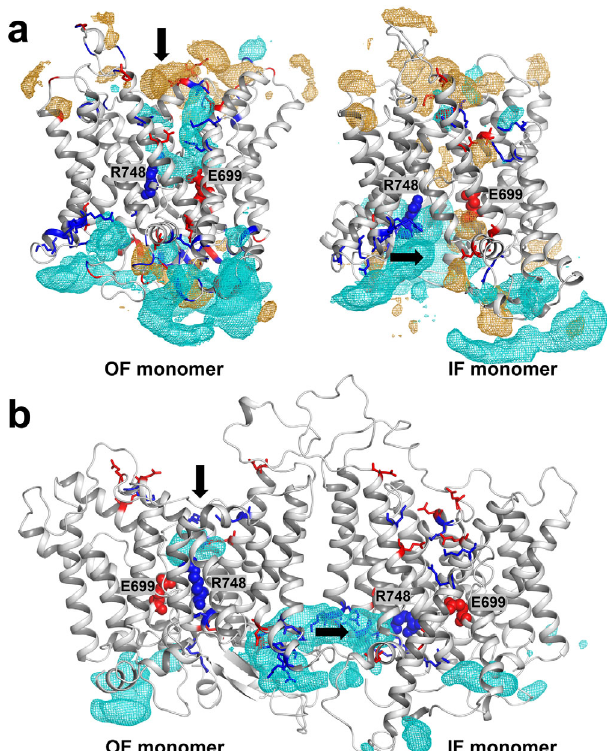
Fig. 4 SILCS and MD simulations of AE1. a Cation (orange mesh) and anion (cyan mesh) maps from SILCS simulations of AE1 monomers visualized at Grid Free Energy level of − 0.9 kcal/mol. b Average HCO 3 − density maps (cyan mesh) calculated from 1 µ s MD simulations of three IF – OF replicas (contour isovalue 0.05). Positively and negatively charged residues lining the IF and OF permeation cavities are shown as blue and red sticks, respectively. Residues R748 and E699 from the central site S1 in the OF state are shown as blue and red spheres, respectively. The ion entry pathways in the OF and IF cavities in the monomers and the dimer are presented as black arrows (vertical for ion permeation in the OF cavity and lateral for ion permeation in the IF